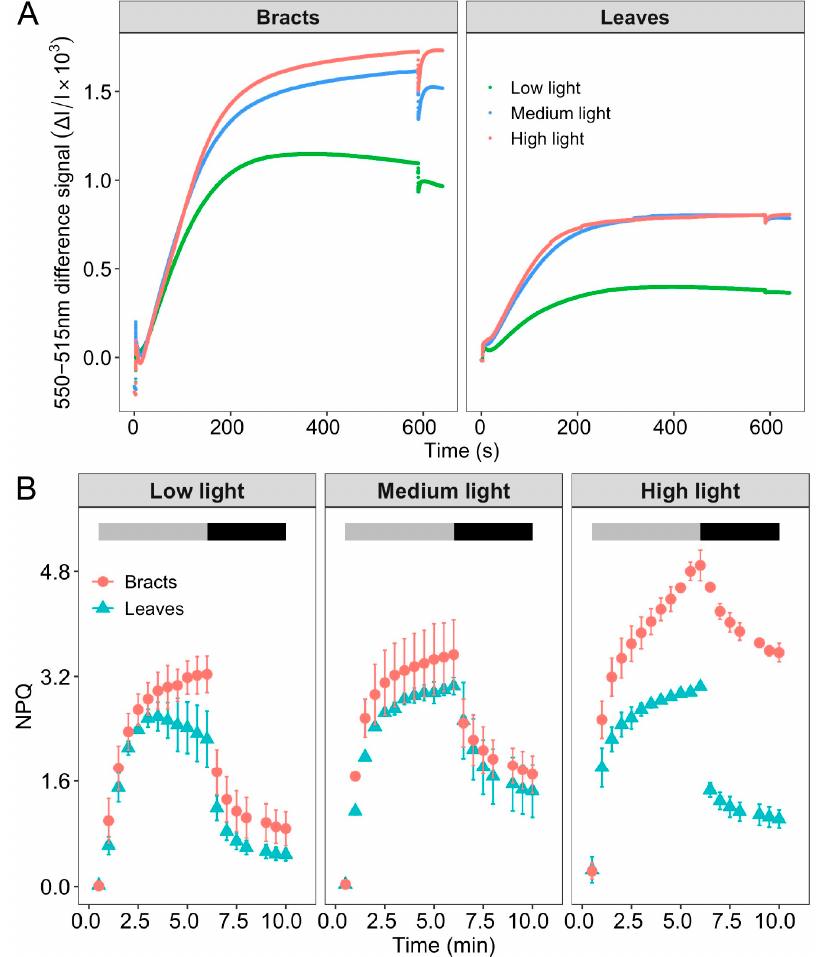
Figure 5. Changes in heat dissipation in cotton leaves and bracts after exposure to different durations of three different light intensities of 400 μ mol m − 2 s − 1 (low light), 1800 μ mol m − 2 s − 1 (medium light), or 2800 μ mol m − 2 s − 1 (high light). ( A ) Slow dark–light–dark induction transients of the 550– 515 nm signal in leaves and bracts in different light intensities. ( B ) Changes of NPQ in leaves and bracts under different light intensities. Bars indicate mean and SD ( n = 3).